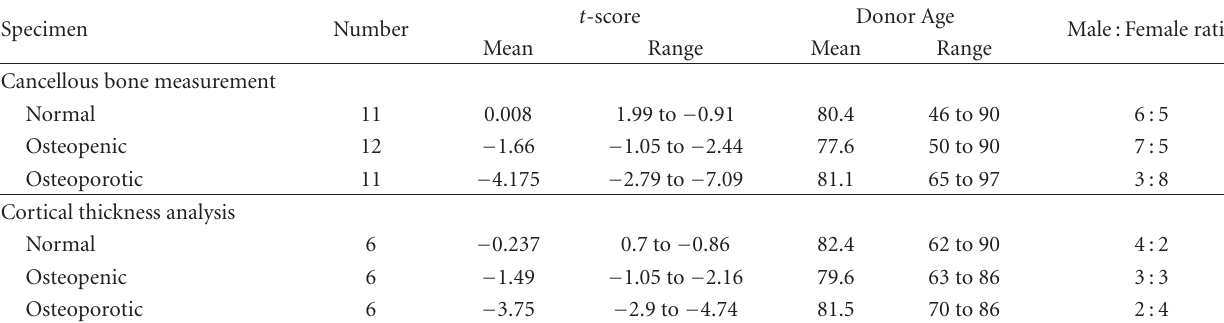
Table 1: Demographics of